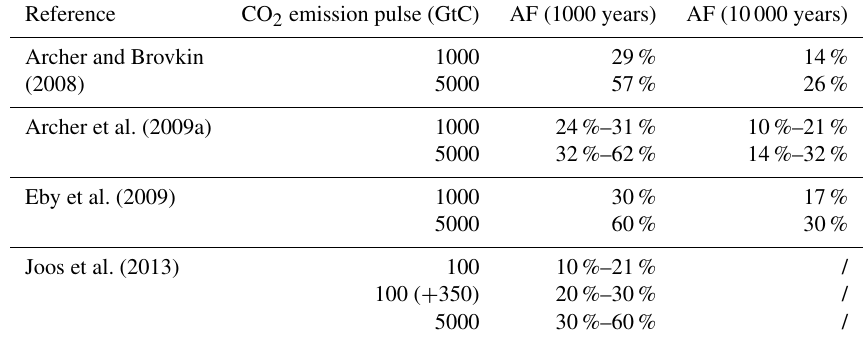
Table A1. Estimates of CO 2 airborne fractions available in the literature 1000 and 10000 years after a pulse of CO 2 into the atmosphere.